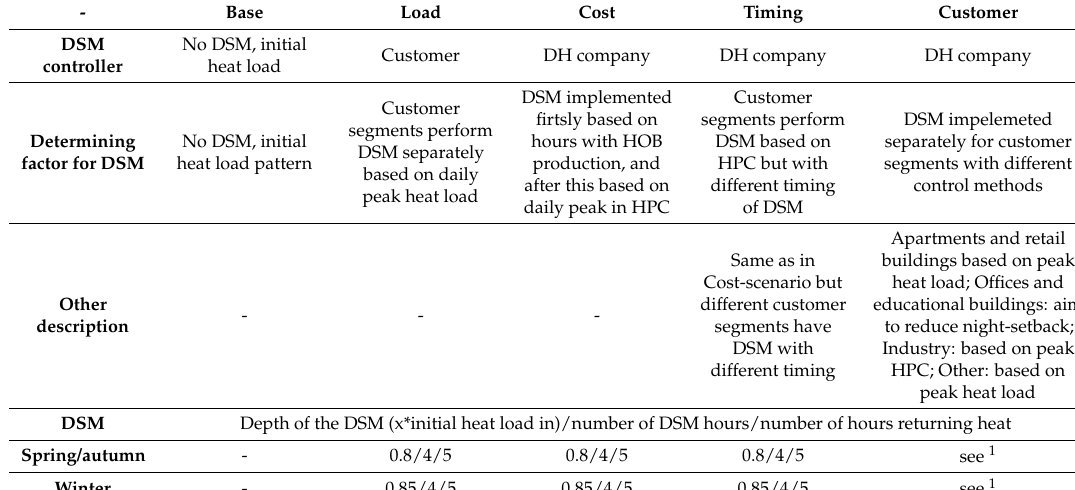
Table 1. DSM scenarios for simulations and factors determining